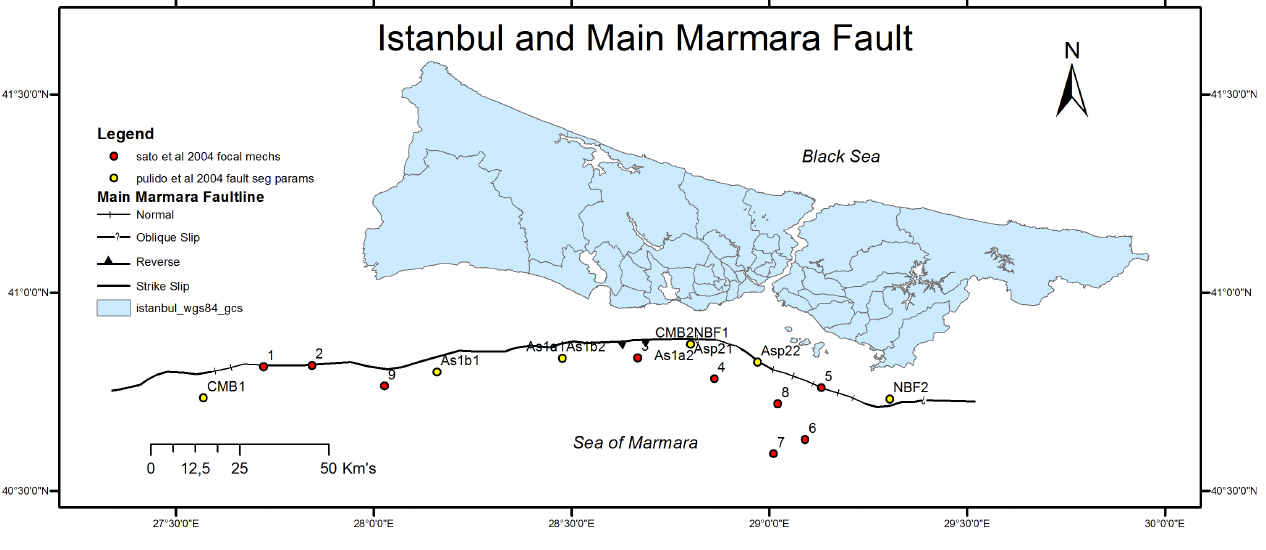
Fig. 2. Main marmara fault line and the focal parameter locations.